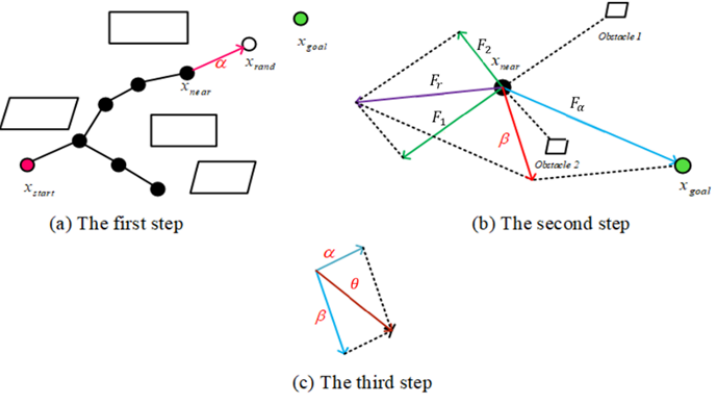
Figure 4. Realization of the steer algorithm in three steps. The steer function Algorithm 3 is described as: Algorithm 3: Steer ( x rand , x near , x tar , map , stepsize